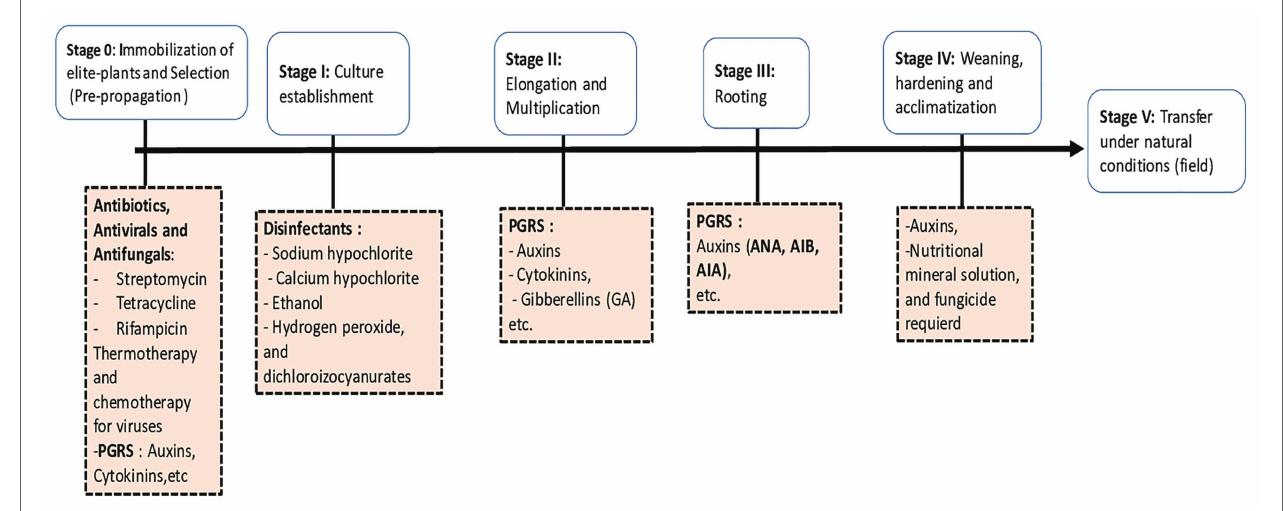
FIGURE 1 | Main stages of micropropagation and required chemical components for each step.